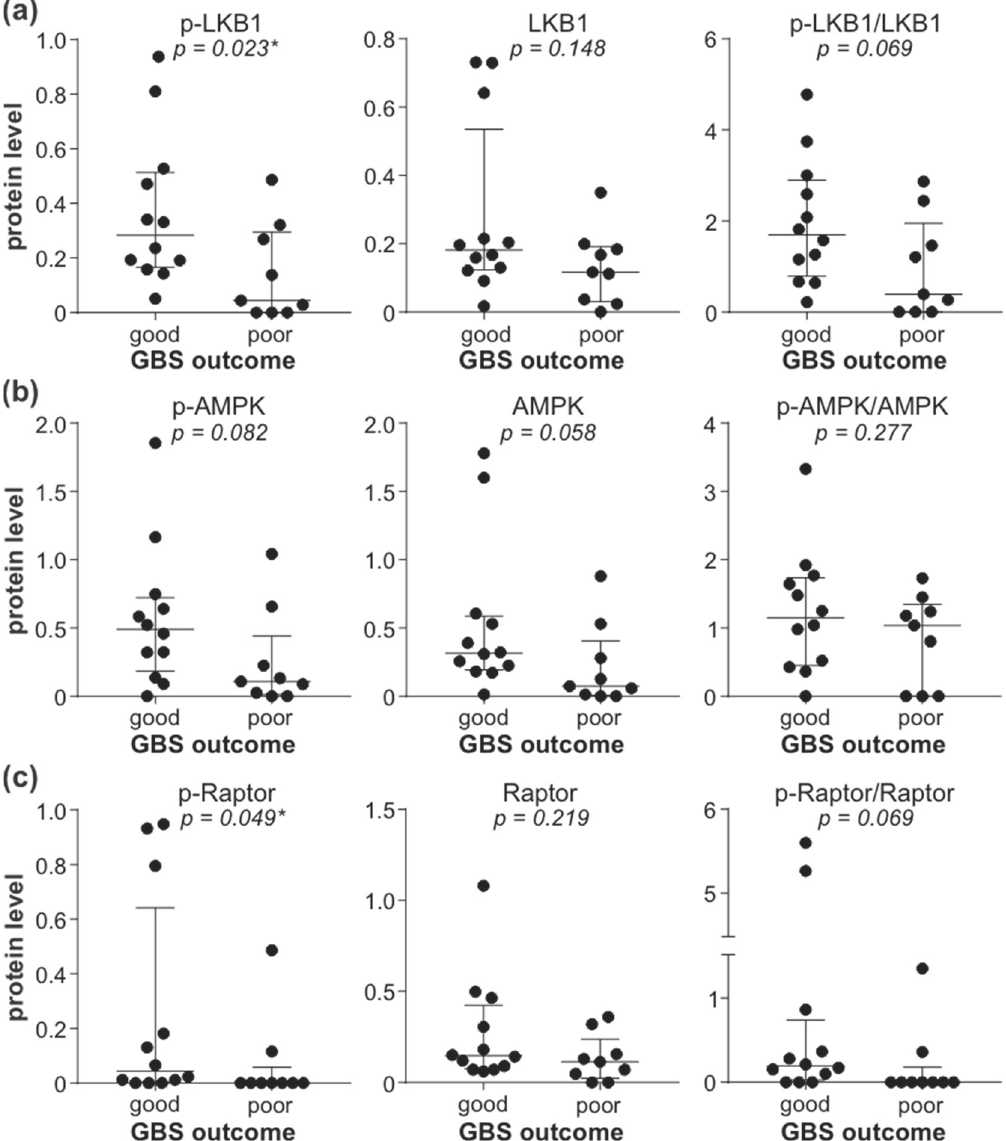
Figure 5. Association of leukocyte AMPK signaling with GBS outcome. The levels of phosphorylated, total, and phospho/total ratio of LKB1 ( a ), AMPK ( b ), and Raptor ( c ) in PBMCs of GBS patients ( n = 21) were determined by immunoblotting and compared between patients with good (GDS ≤ 1, n = 12) and poor (GDS > 1, n = 9) disease outcome at 6 months (horizontal lines represent median and interquartile range; * p < 0.05, two-tailed Mann–Whitney U test).